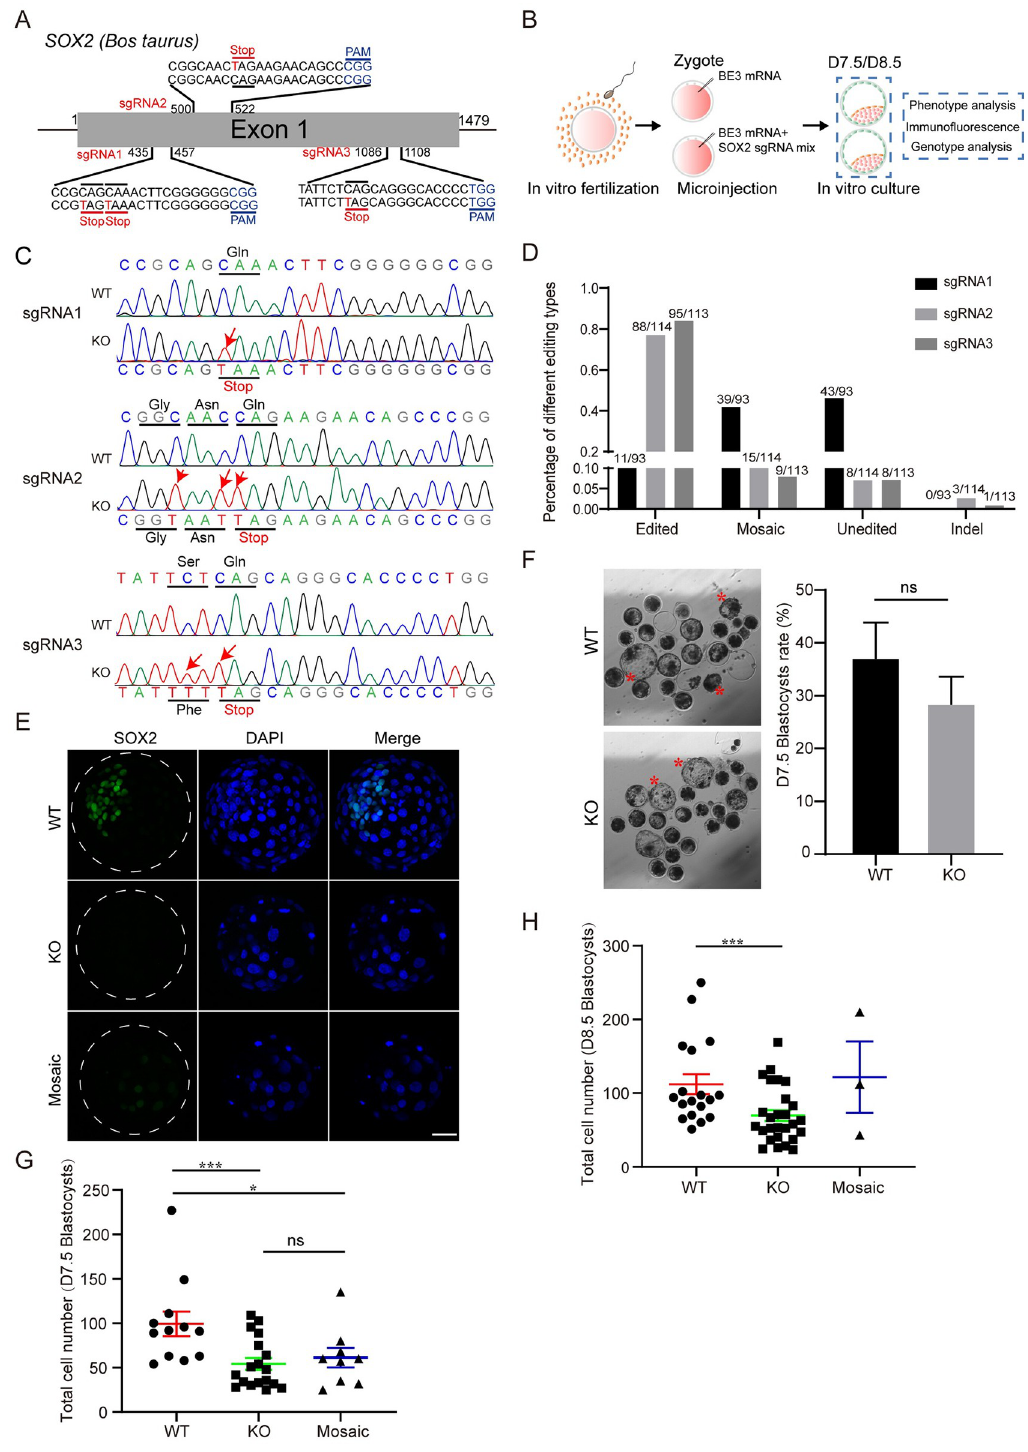
Fig 3. Effects of SOX2 knockout on bovine early embryonic development. A. sgRNAs used to target SOX2 . Red lines represent the position of introduced premature stop codon. B. Experimental design to explore the effects of SOX2 KO on bovine early embryonic development. C. Representative genotyping results for three distinct sgRNAs. WT: wild-type; KO: putative SOX2 knockout embryos. Red arrows denote successful C: T conversion. D. Statistical analysis of editing efficiency for each sgRNA. The target sequence of sgRNA1, sgRNA2 and sgRNA3 were analyzed in 93, 113 and 114 embryos, respectively.